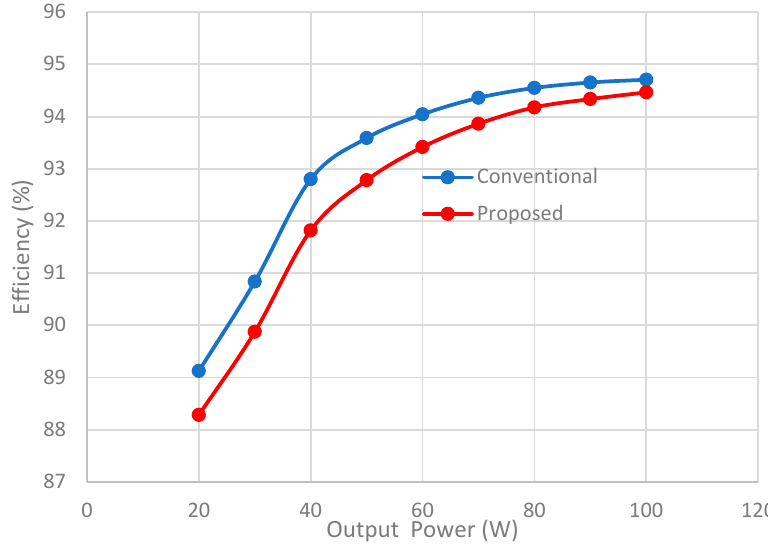
Figure 14. Efficiency comparison.